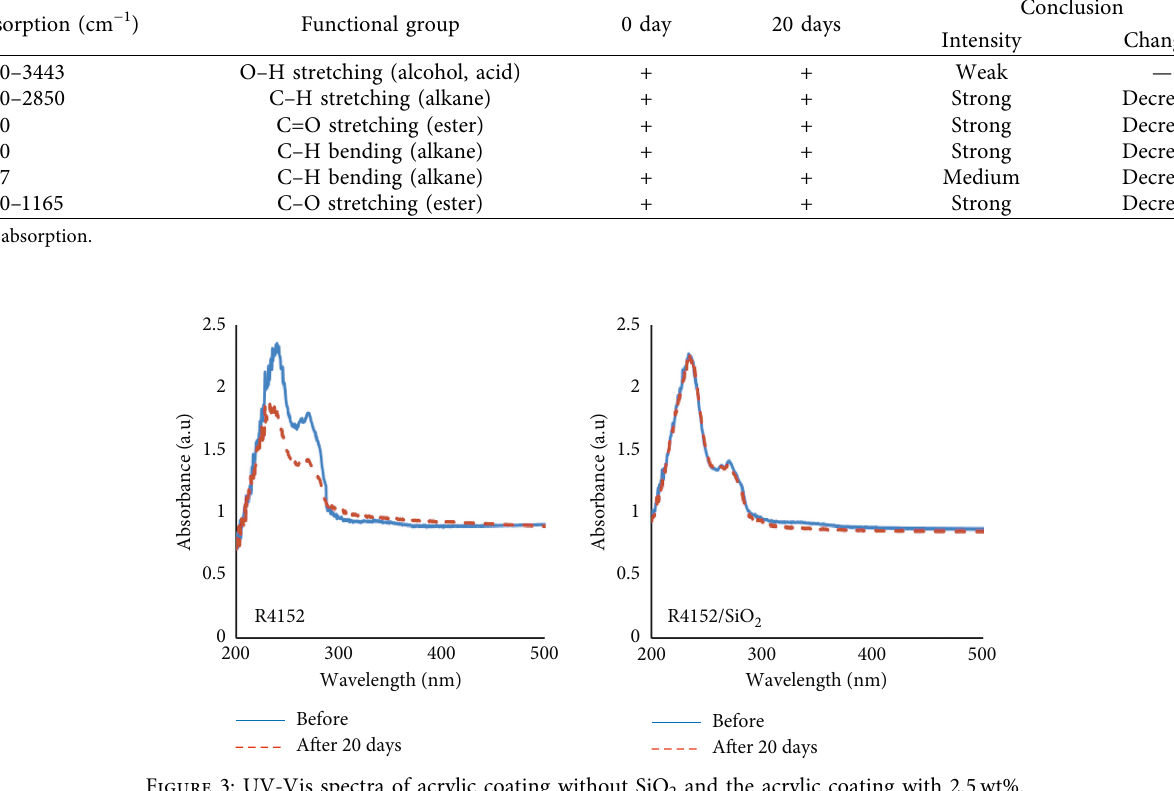
2 and the acrylic coating with 2.5 wt%.